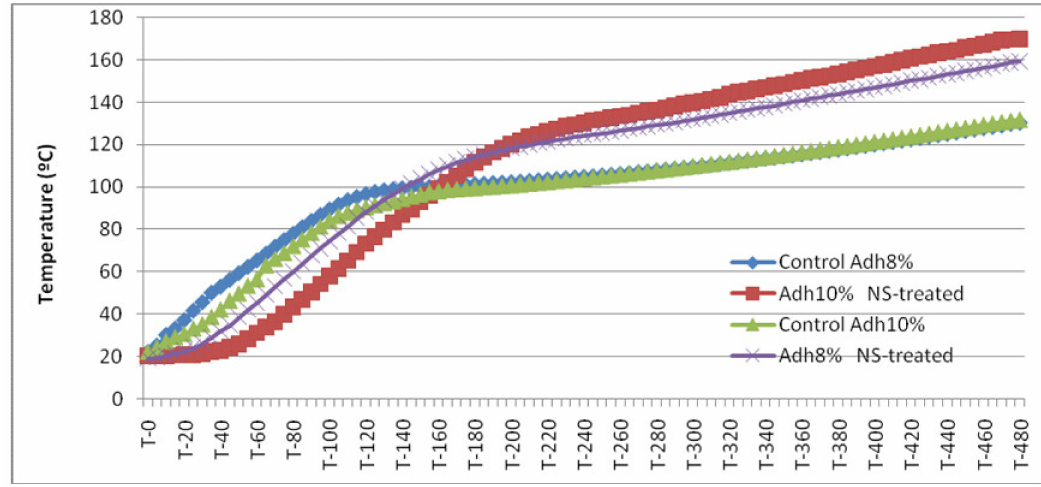
Figure 7. Mean core temperature ( ◦ C) at 5 s intervals for the four treatments